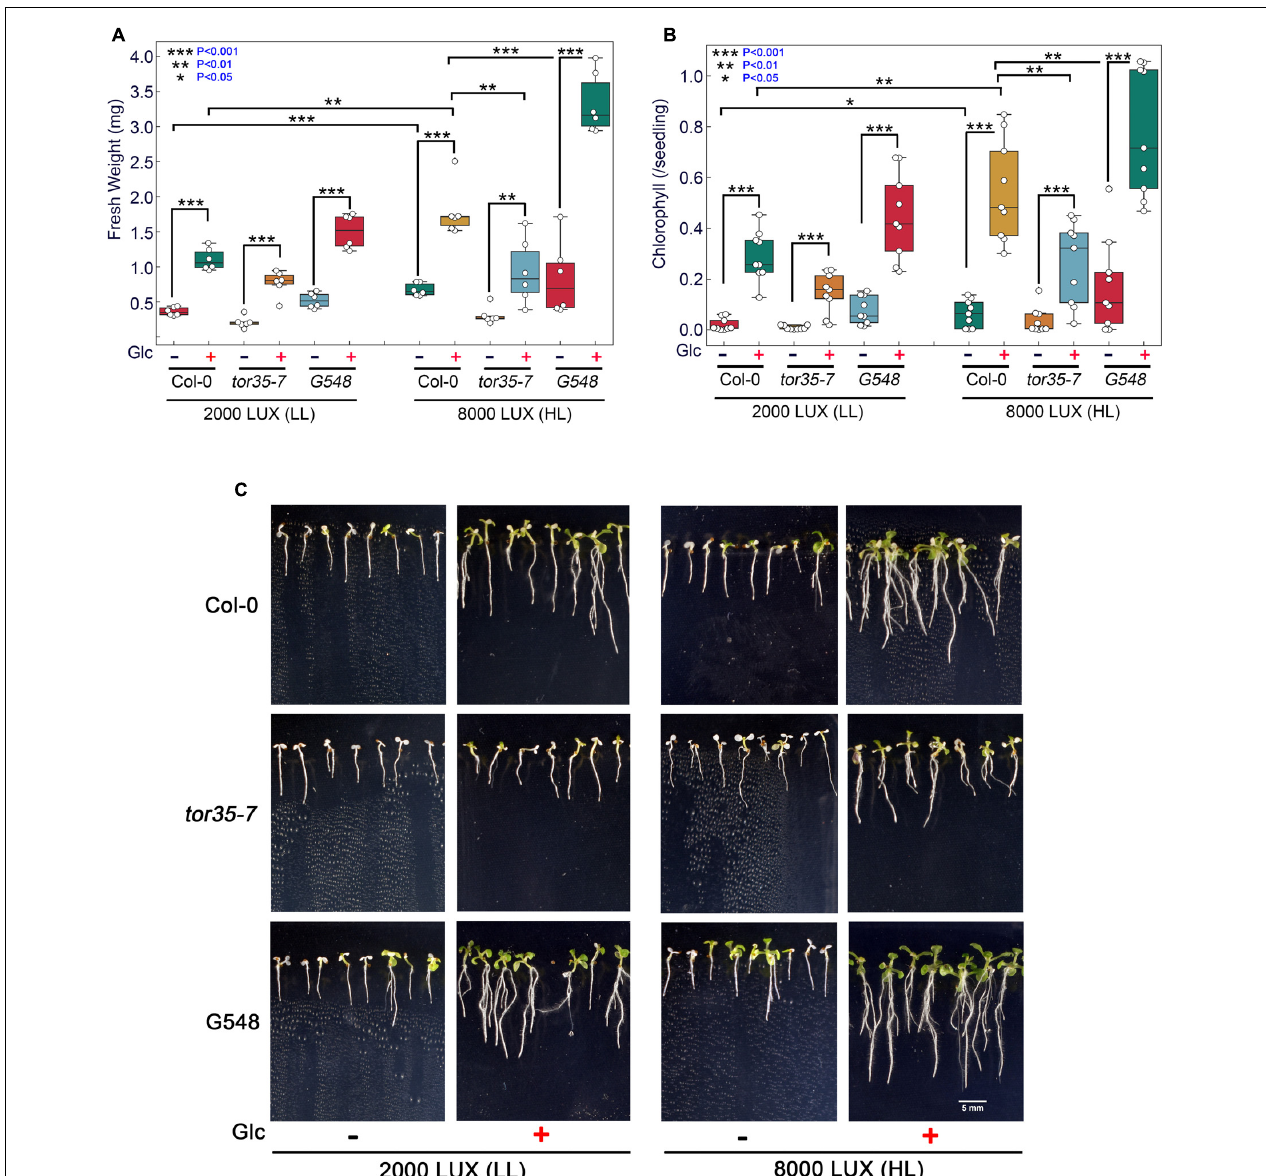
FIGURE 1 | Increasing light intensity mimics the Glc-TOR-mediated thermotolerance response. (A,B) Measurement of fresh weight and Chl content of Arabidopsis Col-0, tor35-7 RNAi and TOR overexpression (G548) line grown under low (2000 LUX; LL) and high (8000 LUX; HL) light intensities without or with Glc (90 mM) and after HS. (C) HS phenotype of Col-0, tor35-7 , and G548 grown under LL and HL. Arabidopsis seedlings were grown directly onto 0.5X MS medium containing without or with Glc (90 mM) Glc for 7 days under LL and HL intensities and then transferred to HS. HS was applied as 1 h_37 ◦ C, 2 h_22 ◦ C, and 2.5 h_45 ◦ C, followed by recovery at 3–7 days_22 ◦ C under normal light (5000 LUX; NL) intensity. Data shown are representative of three biological replicates, each containing two (FW) and three (Chl) technical replicates with at least 20 seedlings. Experiments were independently repeated three times ( n = 3) with similar results. (***